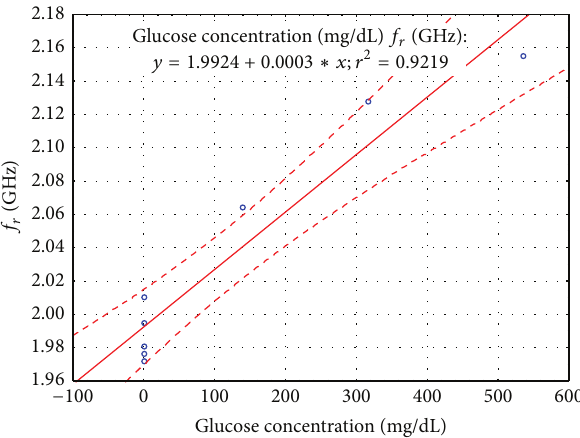
Figure 7: Dependence of sensor resonant frequencies on glucose concentration of pig blood-glucose solutions; dashed red lines denote 95% confidence